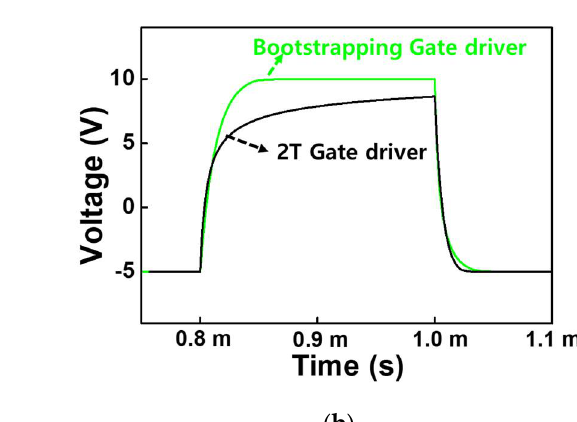
Figure 3. ( a ) Simulated waveforms for both the proposed circuit and 2TFT circuit; ( b ) comparison between two outputs. Table 1. Comparison of driving characteristics of the proposed circuit and 2TFT circuit.